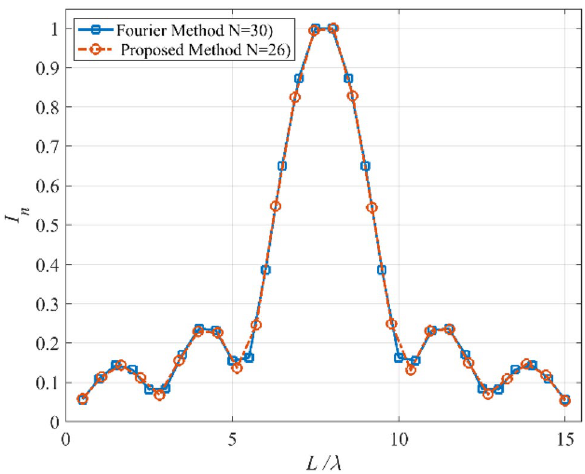
Figure 10. The obtained I n ’s of the third case.